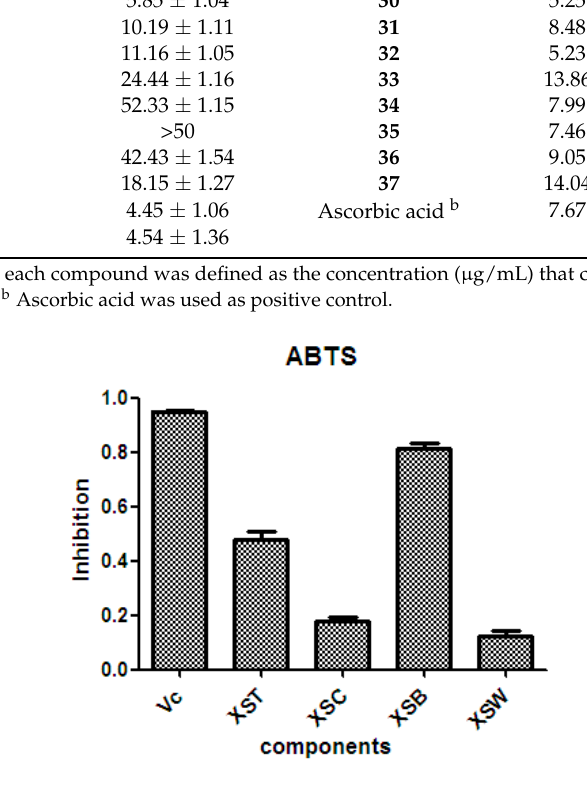
Figure 5. The radical-scavenging activity of the crude samples from X. sorbifolia husks. ABTS was prepared daily and diluted to an absorbance of 0.70 ± 0.02 at 734 nm. After the crude samples (50 µ g/mL) reacted with the ABTS radical solution for 10 min, the absorbance values ( Ai ) at 734 nm were measured, and the percentage inhibitions were calculated. Vc, ascorbic acid; XST, 70% aqueous ethanol extract; XSC, chloroform soluble fraction; XSB, n -butanol soluble fraction; XSW, water soluble fraction. PTX, Paclitaxel.